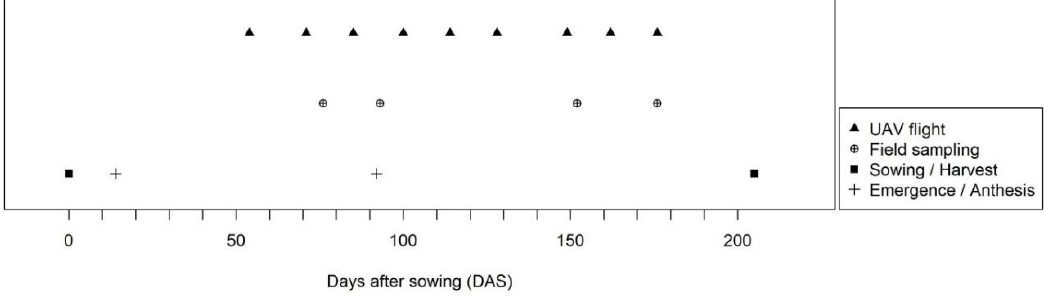
Figure 2. Timing of AGB biomass sampling and UAV flight surveys. The field crop was sown on 21 April (0 days after sowing (DAS)) and harvested on 13 November (205 DAS) 2015. The emergence and the anthesis occurred on 6 May and 23 July, respectively.